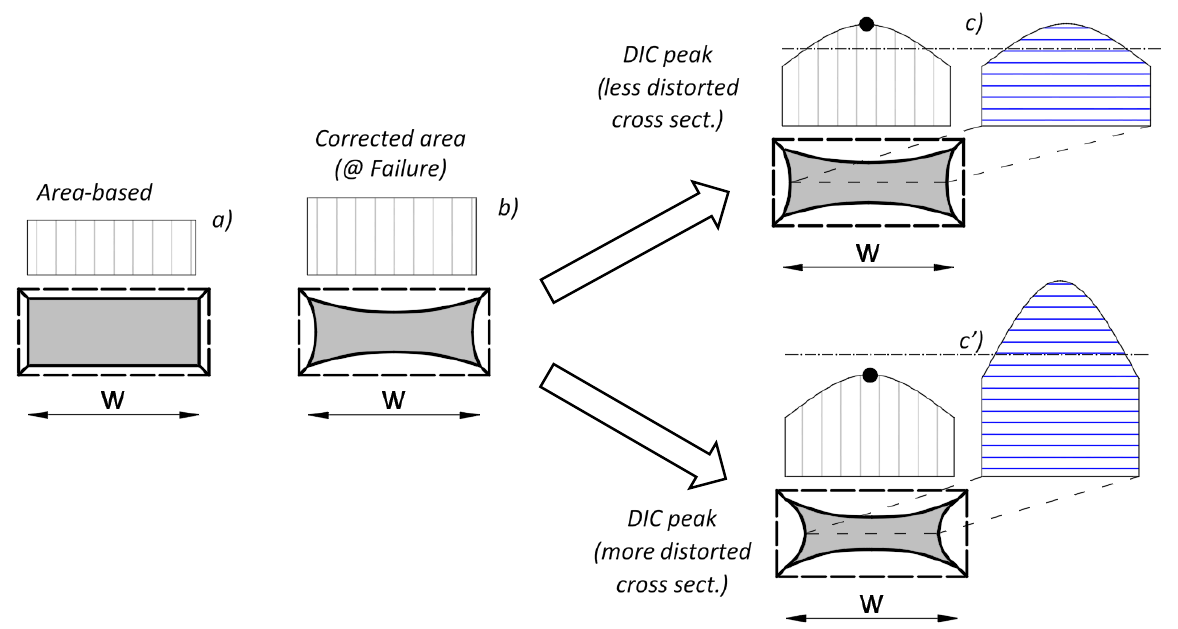
Figure 9. Different possible evaluations of the postnecking strain: ( a ) Area-based, ( b ) corrected area at failure, and DIC peak in the case of less distorted cross-section ( c ) and more distorted cross-section ( c’ ).